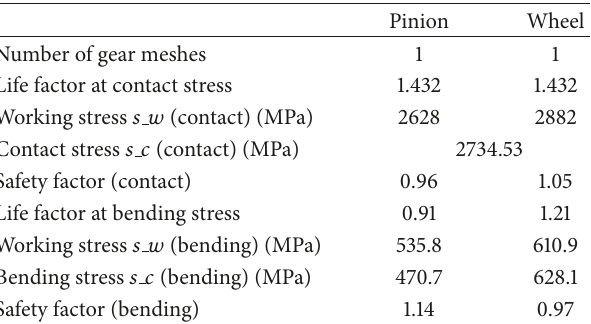
Table 3: Contact and bending stress and safety factor of optimized spiral bevel gears.